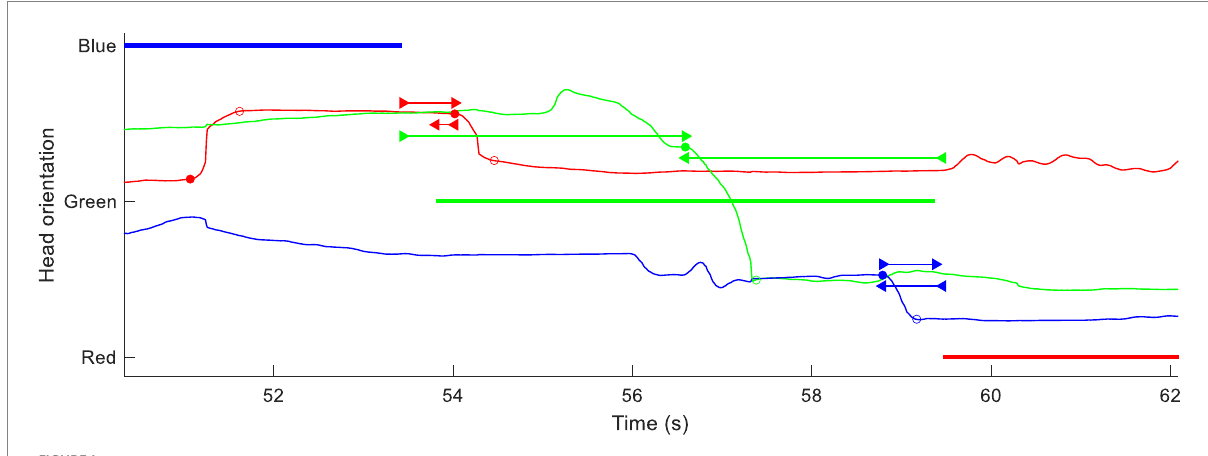
FIGURE 1 Example of Hadley et al. data (group #1 session #2 in babble, analysis of non-overlapping dialogue). Colour-coded VAD data (thick lines) with superimposed head-yaw data (thin lines) using the same colours of a given interlocutor. Head yaw has been transformed so that the curve moves coherently between the three VAD data lines for the respective talker directions. Detected head saccades are marked at their initiation (filled circles) and termination (open circles). Associations between saccade initiation and VAD offsets and onsets are marked by forward- and backward- pointing double-headed arrows,